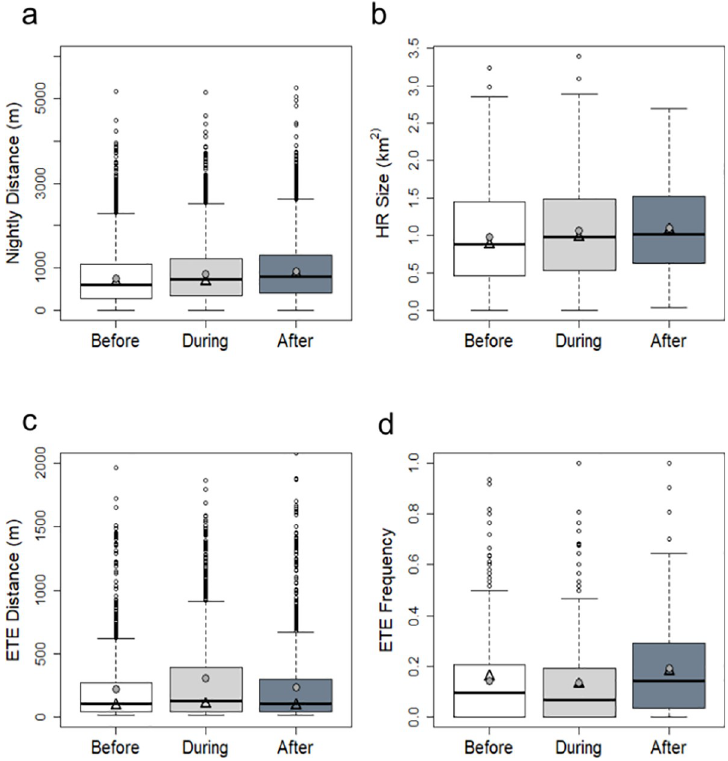
Fig 2. Boxplots for badger movement metrics in each phase of road construction. The before phase is represented in white, the during phase in light grey and the after phase in dark grey. Thick black bars represent cohort medians, filled grey circles represent cohort means and open black triangles represent the medians of individual medians. a) Nightly distance (m) by road construction phase, y-axis limited to 6000m for clarity; b) Home range size (km 2 ) by road construction phase; c) ETE distance (m) by road construction phase, y-axis limited to 2000m for clarity and d) ETE frequency (proportion between 0 and 1) by road construction phase.